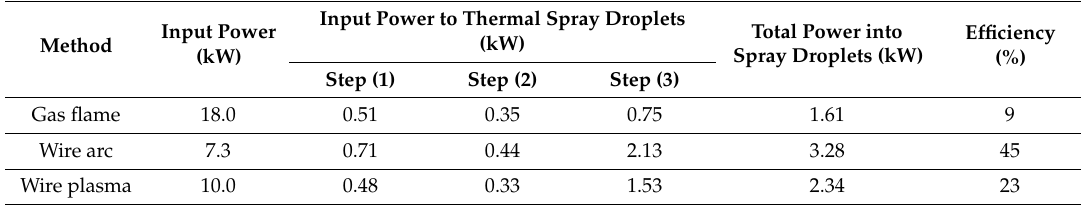
Table 5. Powers to guns and various heating powers to spray droplets, together with power efficiencies for three thermal spray